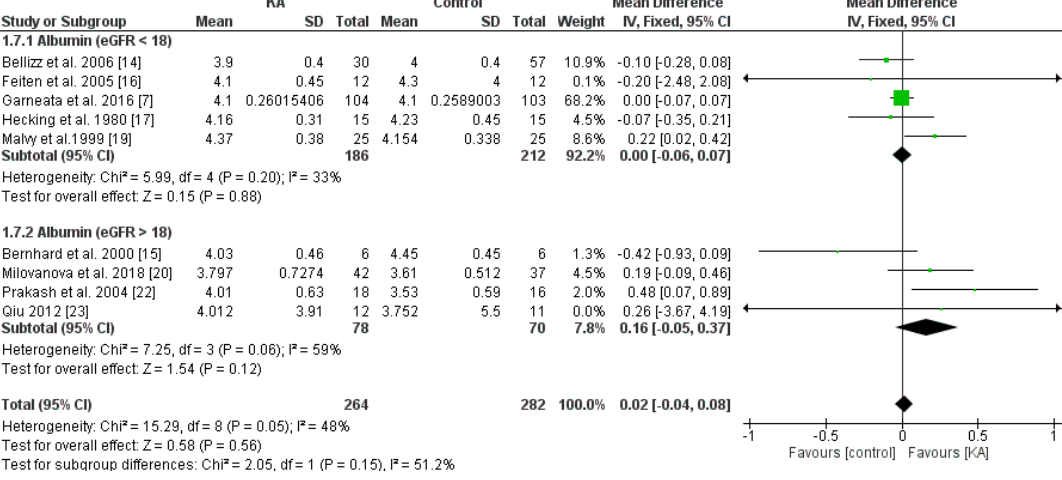
Figure 7. Forest plot of e ff ects of KA on albumin levels in CKD patients sub-grouped by eGFR. The random-e ff ects model was